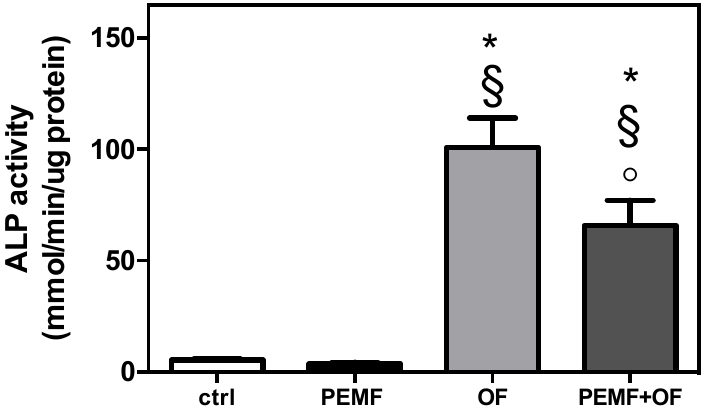
Figure 2. Alkaline phosphatase (ALP) activity after 21 days. ALP activity was colorimetrically determined, corrected for the protein content (measured with the BCA Protein Assay kit), and expressed as mM of p-nitrophenol produced per min per µ g of protein. Bars express the mean ± SD (N = 3; n = 2, symbols indicate statistical significance vs. control (*), vs. PEMF (§) and vs. OF (°)).